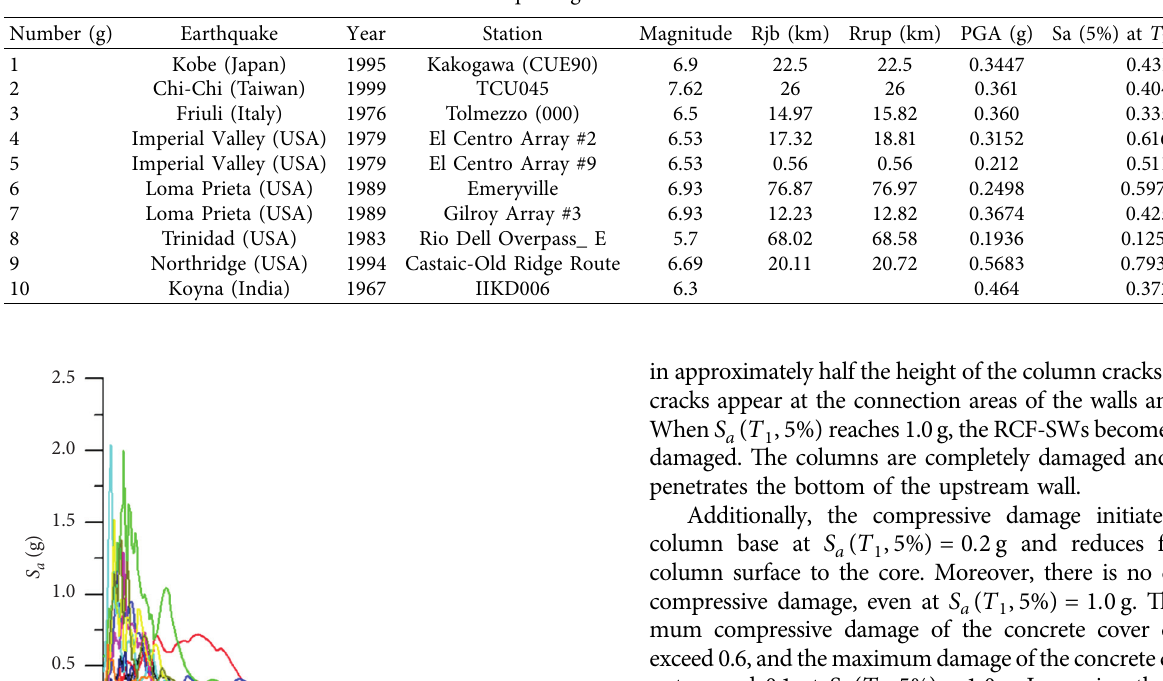
Figure 8: Uniaxial stress-strain and damage-strain curves of concrete. (a) Compression and (b) tension. Table 4: Earthquake ground motions used in the IDA.